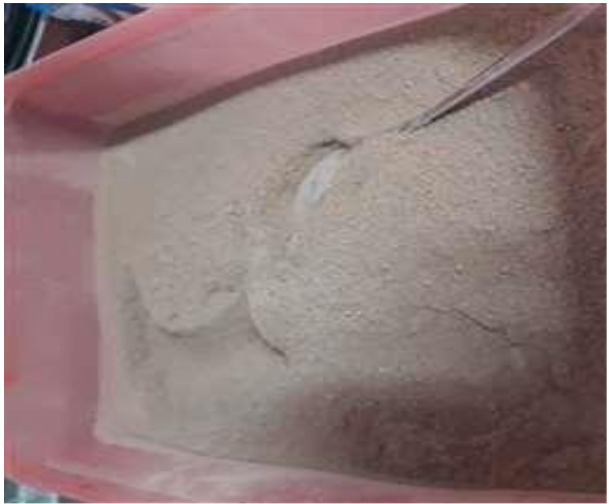
Figure 4. Mangrove/ lindur fruit